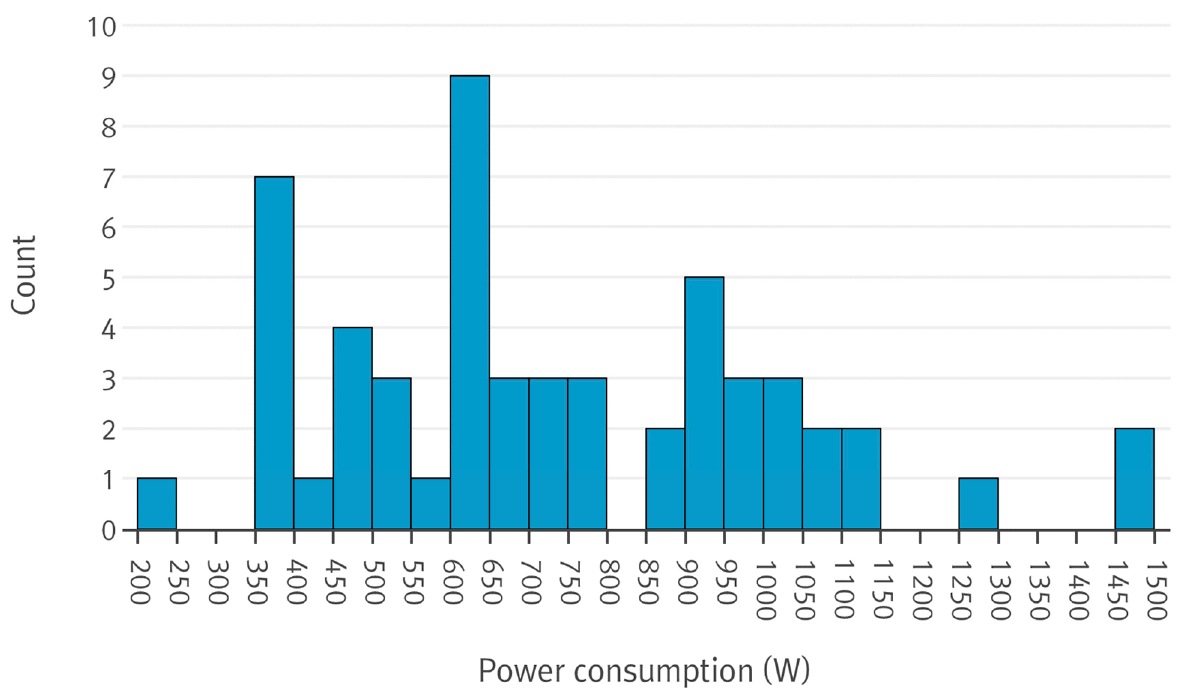
Figure 4. Histogram of the power consumption in the target classrooms.